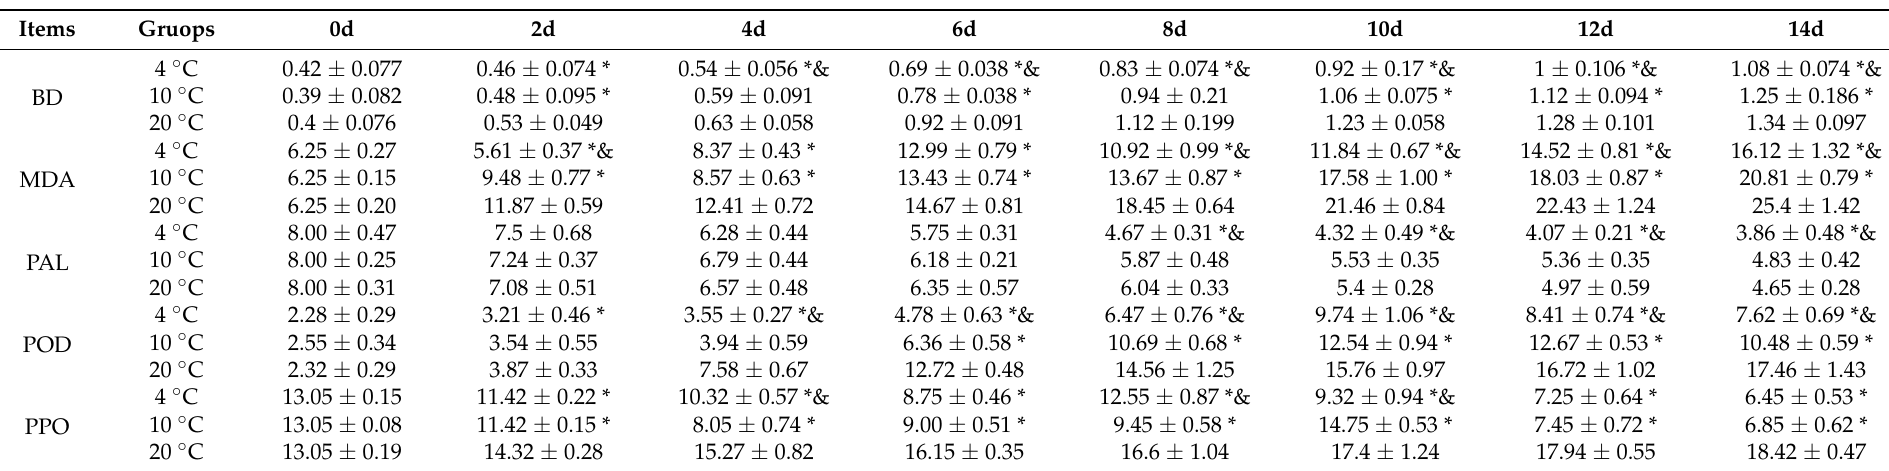
Table 1. The effects of different temperatures on the BD, MDA content, PAL activity, POD activity and PPO activity of Lanzhou lily